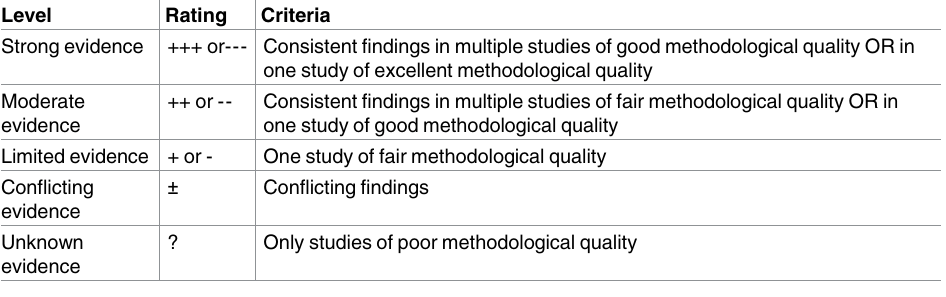
Table 2. Levels of evidence synthesis for methodological quality of paper and consistency of clini- metric evidence of measurement property.